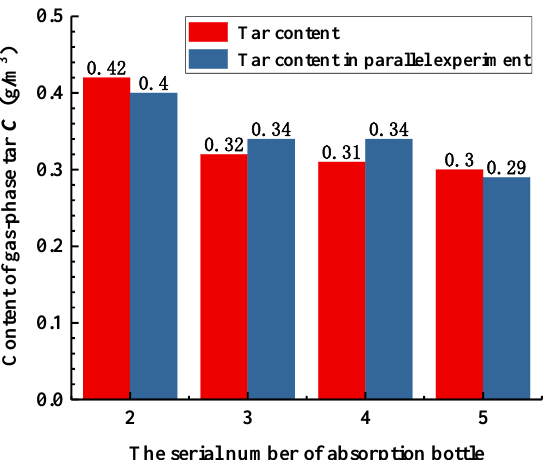
Figure 8. Absorption efficiency in the different conical flasks (No. 2, No. 3, No. 4 and No. 5) for gas- phase tar. gas-phase